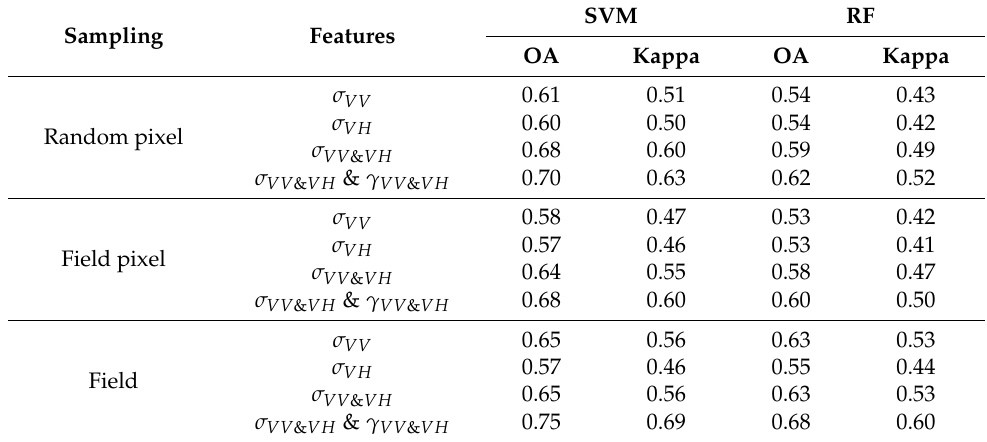
Table 2. The calculated overall accuracy and kappa coefficient for different features with SVM and RF.